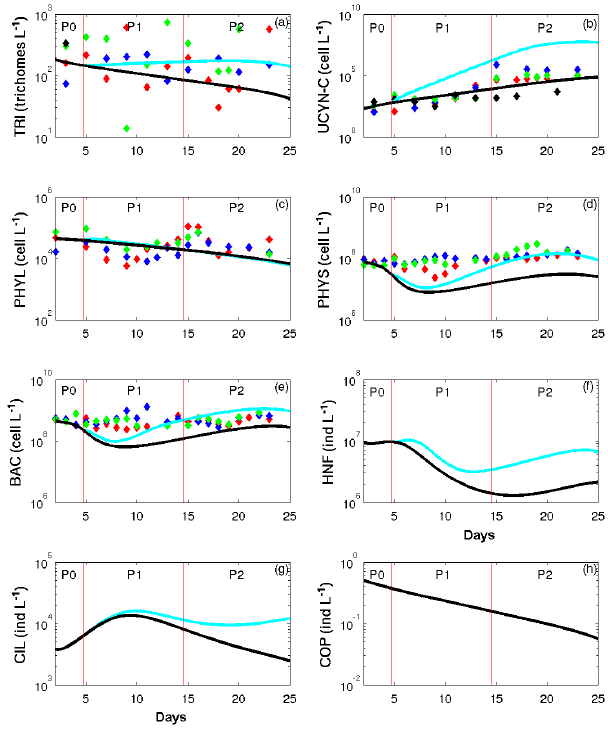
Figure 5. Patterns of change in abundances over time of (a) Trichodesmium (TRI, trichomL − 1 ), (b) unicellular N 2 - fixing cyanobacteria (UCYN-C, cellL − 1 ), (c) large phyto- plankton (PHYL, cellL − 1 ), (d) small phytoplankton (PHYS, cellL − 1 ), (e) heterotrophic bacteria (BAC, cellL − 1 ), (f) hetero- nanoflagellates (HNF, indL − 1 ), ciliates (CIL, indL − 1 ) and cope- pods (COP,indL − 1 ) in model outputs (solid lines: SIM E – blue; SIM C – black) averaged over depth superimposed on data obser- vations averaged over depth in the three mesocosms (M1 – red; M2 – blue; M3 – green) and in surrounding waters (black). Red vertical lines distinguish the three periods P0 (before the DIP en- richment), P1 (diatom–diazotroph associations dominate the dia- zotrophic community) and P2 (unicellular N 2 -fixing cyanobacteria (Group C) dominate the diazotrophic